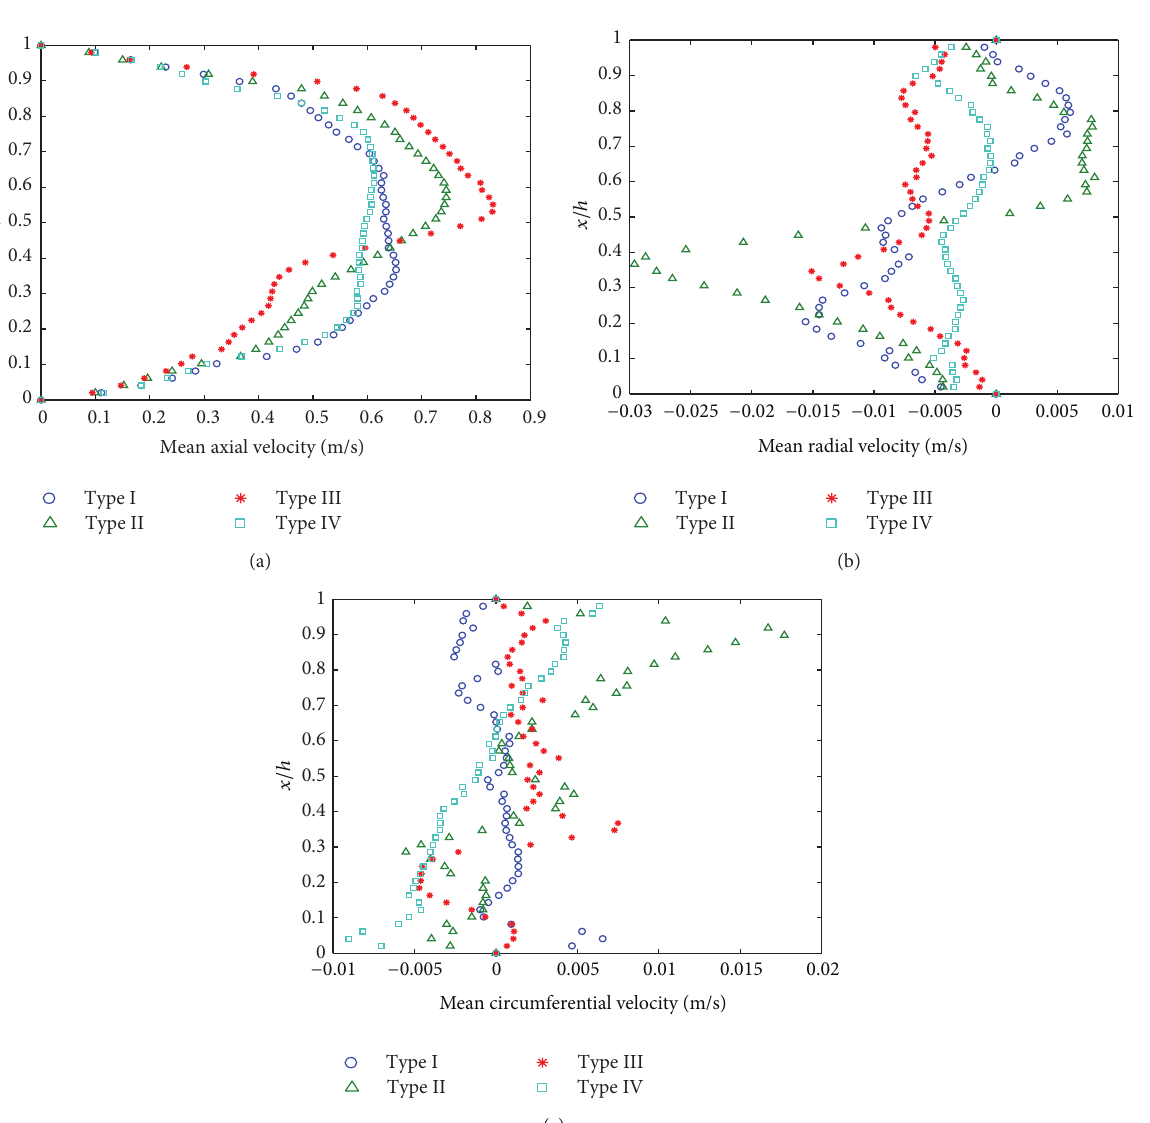
all types have similar mean axial velocity profiles with a maximum mean axial velocity of approximately 0.6 m/s.